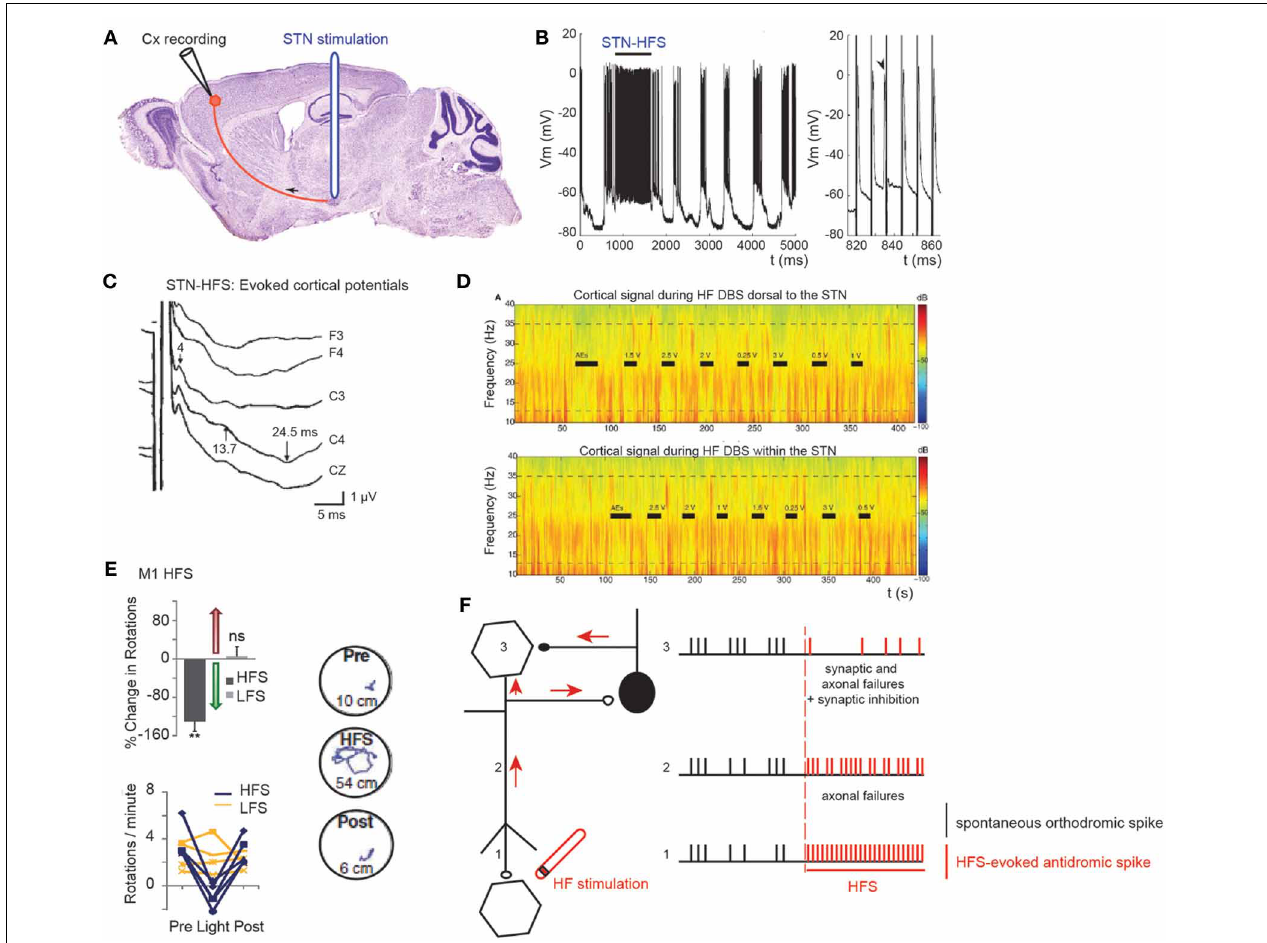
FIGURE 4 | Effect of STN HFS-evoked antidromic spikes on cortical activity. (A) Schematic illustration of the experimental design showing the stimulation and recording sites. (B) Antidromic spiking in cortical neurons evoked by STN-HFS (intracellular recording in the motor cortex). Black bar indicates the period of STN-HFS. Stimulation artefacts are removed. Right trace is a close-up of (B) left. Arrow shows a spontaneous spike before stimulation with subsequent loss of an antidromic spike caused by collision. Adapted from Li et al. (2007). (C) Evoked potentials in the ipsilateral motor cortex in response to bipolar stimulation of the dorsal STN. Latencies of the peaks were 4, 13.7, and 24.5ms. The short-latency negative-evoked potential has a peak latency of 4ms in bilateral frontal and central leads (C3, C4, Cz). Adapted from Kuriakose et al. (2010). (D) STN-HF DBS induces beta attenuation in motor cortex. Spectrogram of single cortical ECoG channel during HF DBS (top) 1.5mM dorsal to the dorsal border of the STN and